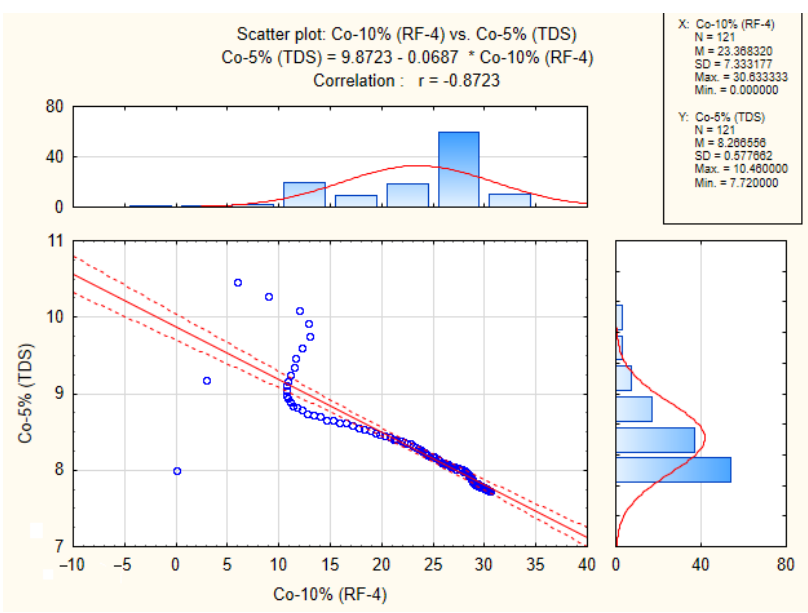
Figure 8. Example of correlation results from STATISTICA CZ version 12 (StatSoft, Inc., USA).